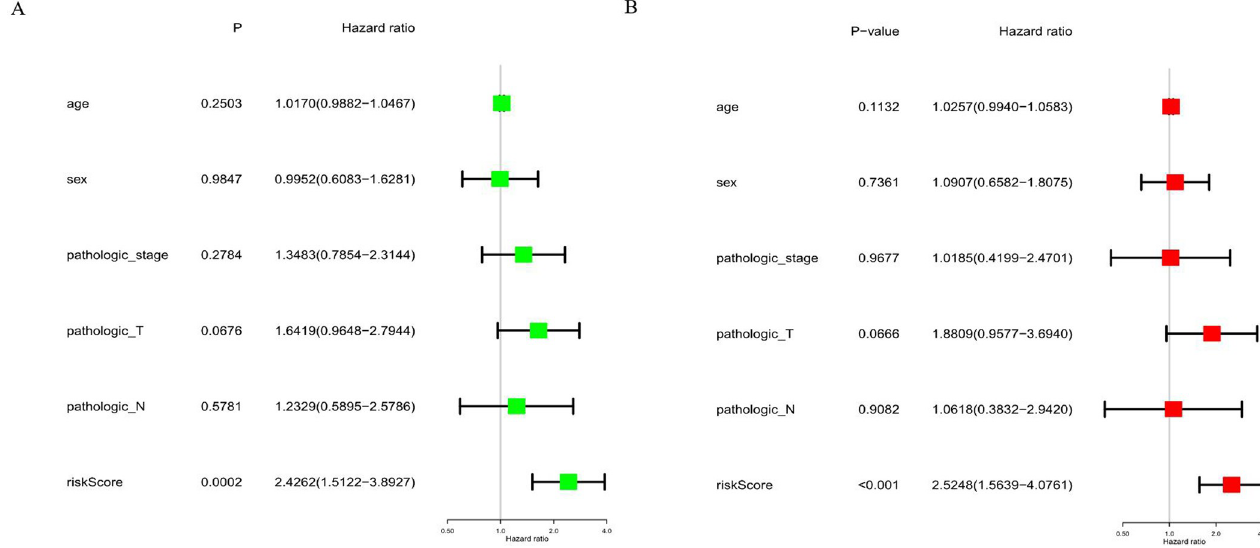
Fig 6. Univariate and multivariate Cox analyses to identify the risk factors. A: Univariate; B: Multivariate.